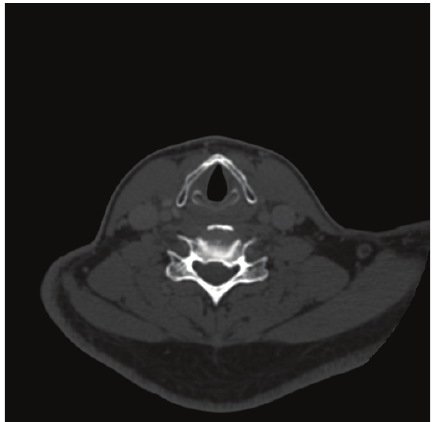
Figure 1: Axial computed tomography image of radiation recurrent glottic cancer shows no evidence of invasive disease into the thyroid cartilage prior to initial salvage surgery.